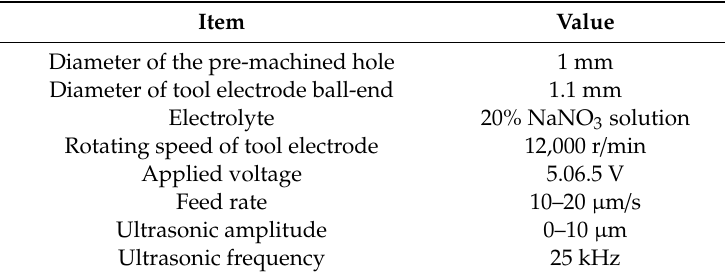
Table 2. Parameters applied in the